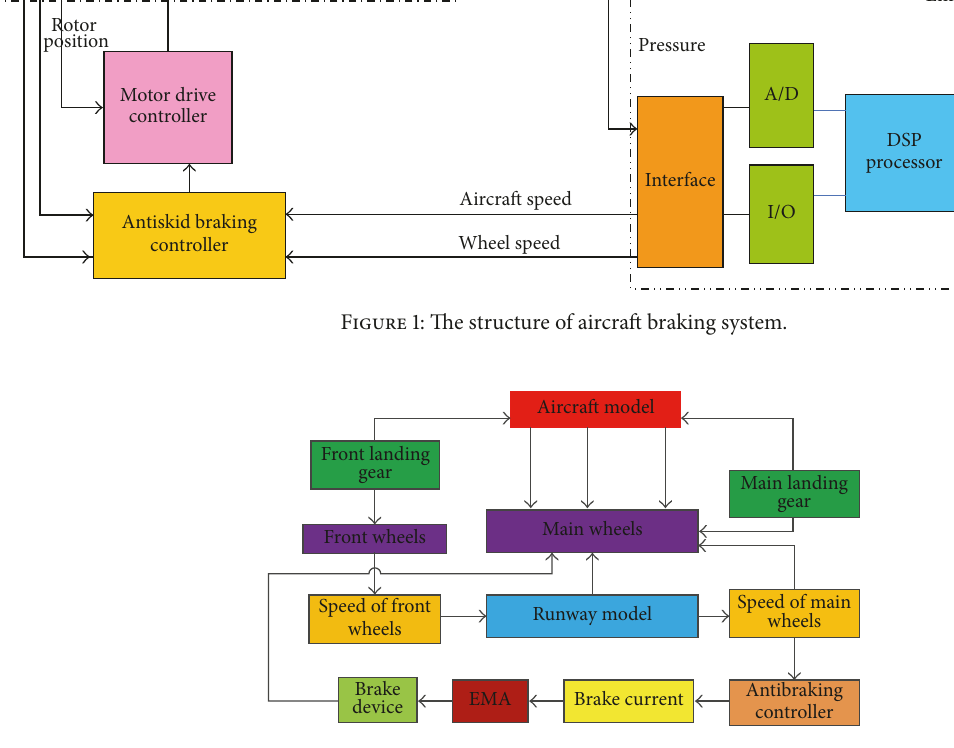
Figure 2: The functional relationship between the various